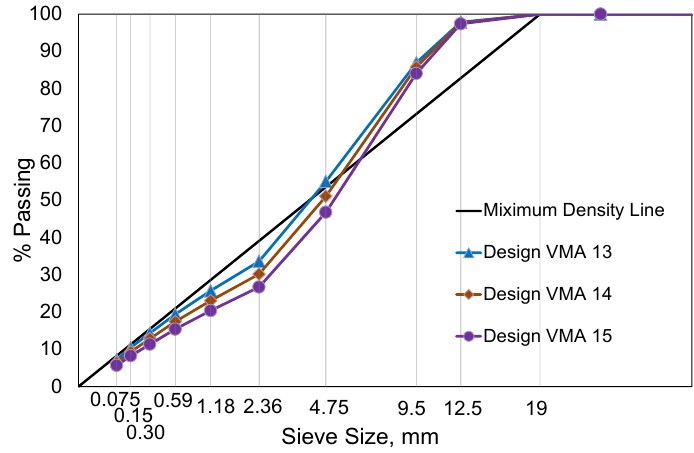
Figure 8. Three di ff erent aggregate gradations for the design VMAs. Figure 8. Three different aggregate gradations for the design VMAs. Table 4. Volumetric mix designs for three di ff erent design VMAs and design air-void contents. Table 4. Volumetric mix designs for three different design VMAs and design air-void